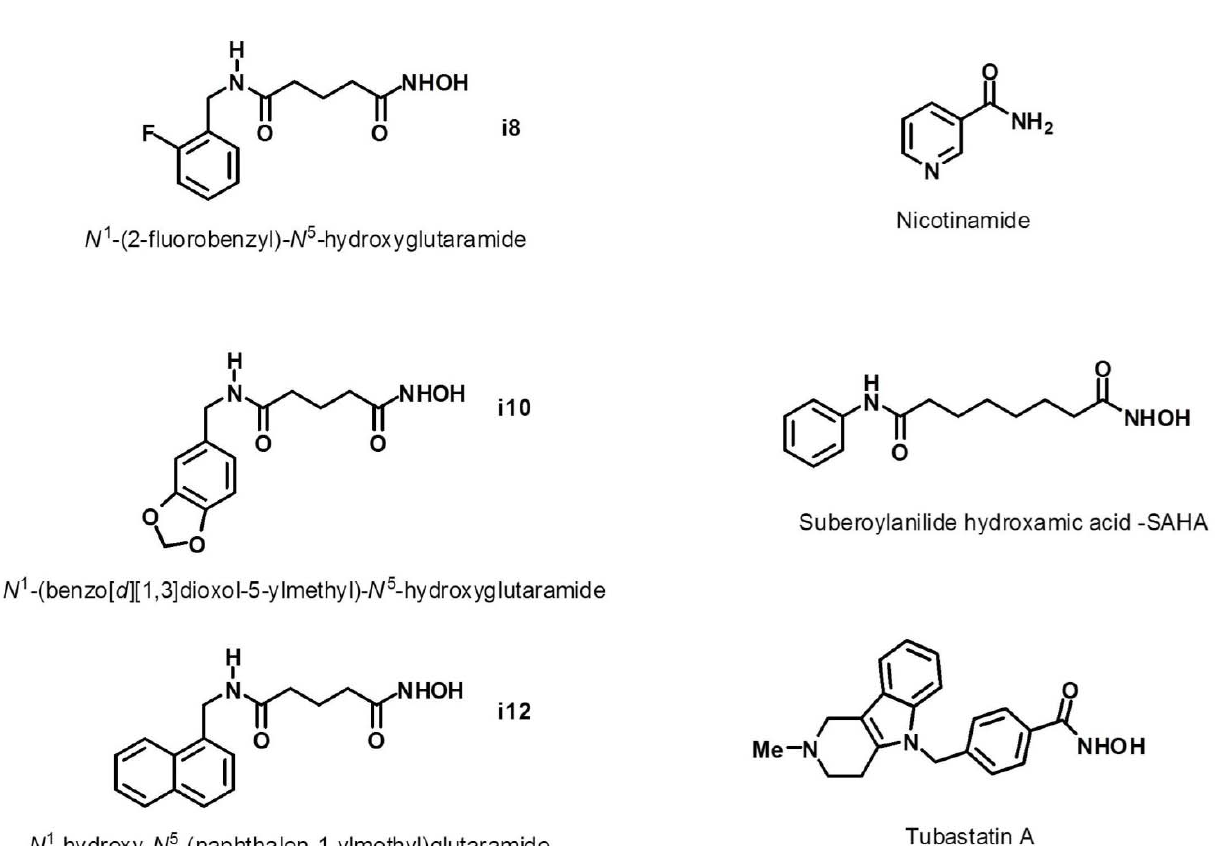
Figure 1. Chemical structures of compounds used for the HDAC and SIRT inhibition explored in this